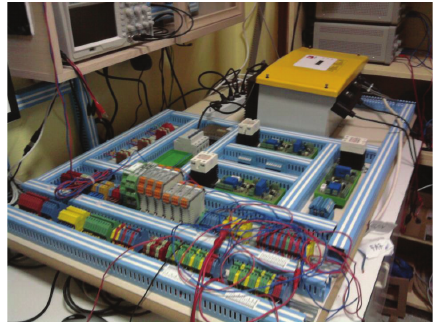
Figure 14: The developing islanding test system in laboratory.